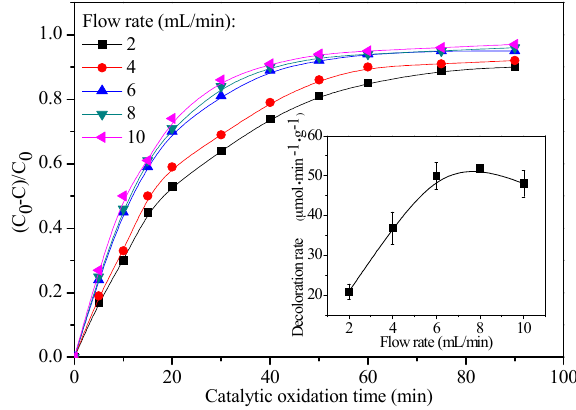
Figure 8. Typical concentration changes of reactive red X-3B (T = 50 °C, pH = 2) with CoPc@BC (1.60 mg) and H 2 O 2 (10 mmol/L) under various flow rates. Inset: Effect of flow rate on the decoloration rate of reactive red X-3B.